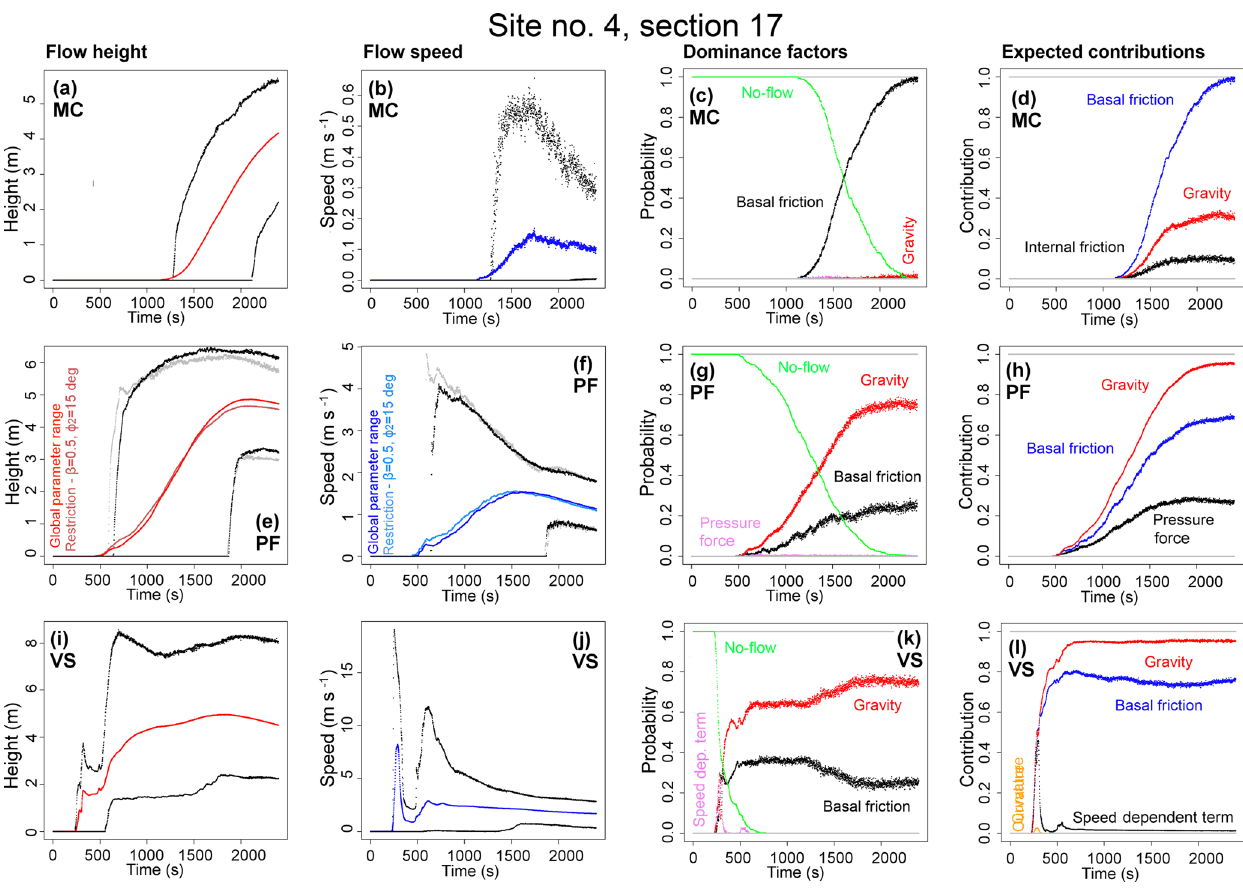
Figure 10. Local flow properties at Site 4, immediately before Atenquique village. Panels (a, e, i) show flow height, (b, f, j) flow speed, (c, g, k) dominance factors, and (d, h, l) expected contributions of the force terms. Different models are plotted separately: (a–d) assume MC, (e–h) assume PF, and (e, f) include estimates on a hyperplanar restriction of the input domain; (i–l) assume VS. In (a, b, e, f, i, j) colored line is mean value, and black and gray lines are 5th and 95th percentile